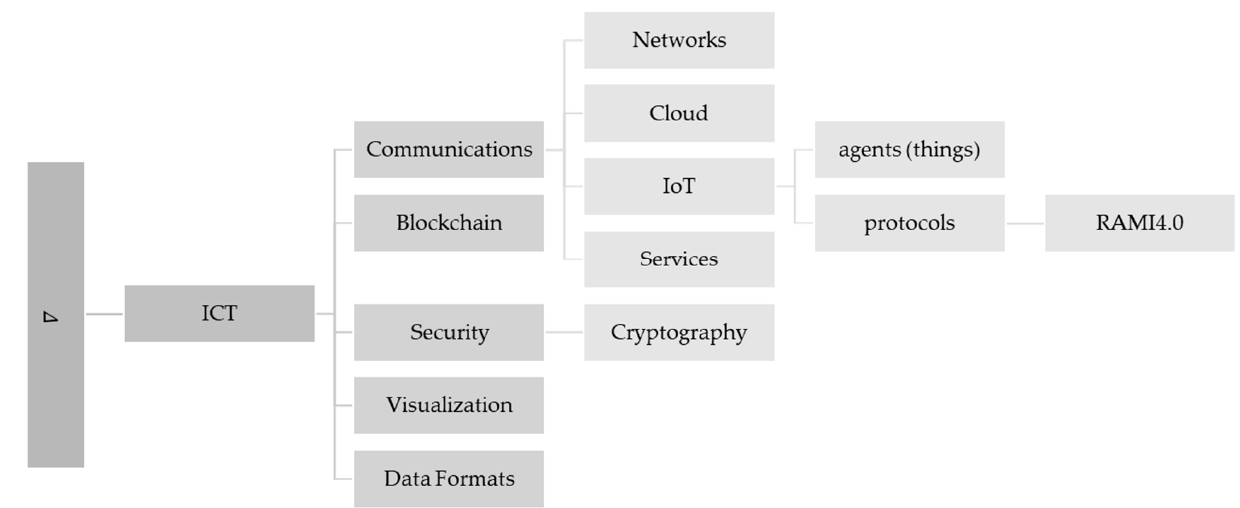
Figure A8. Technologies’ classification: ICT-related branch.